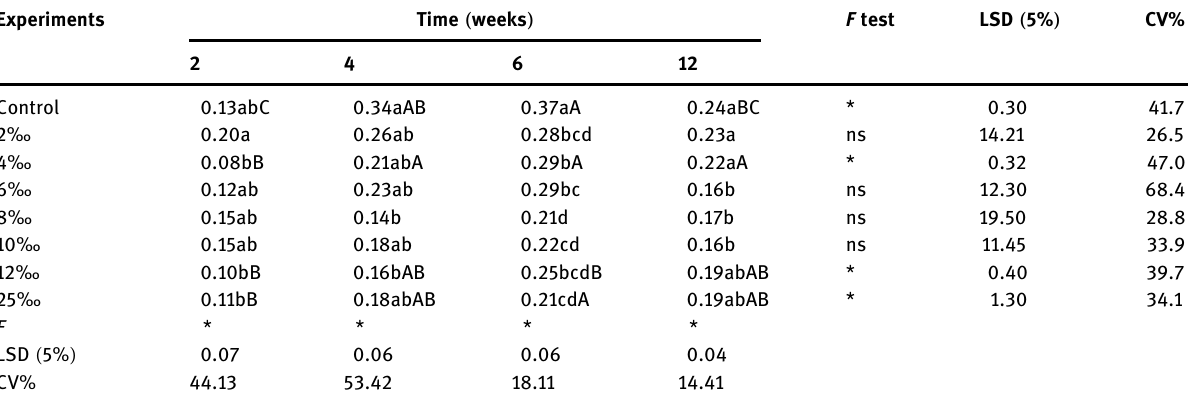
Table 9: E ff ect of salinity treatment duration and available phosphorus concentration ( mg/kg ) in soil Experiments